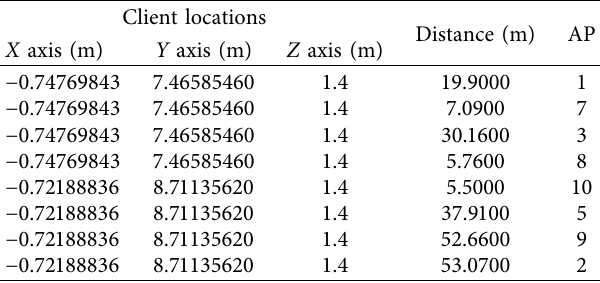
Table 3: An example of measurement data at a certain location.